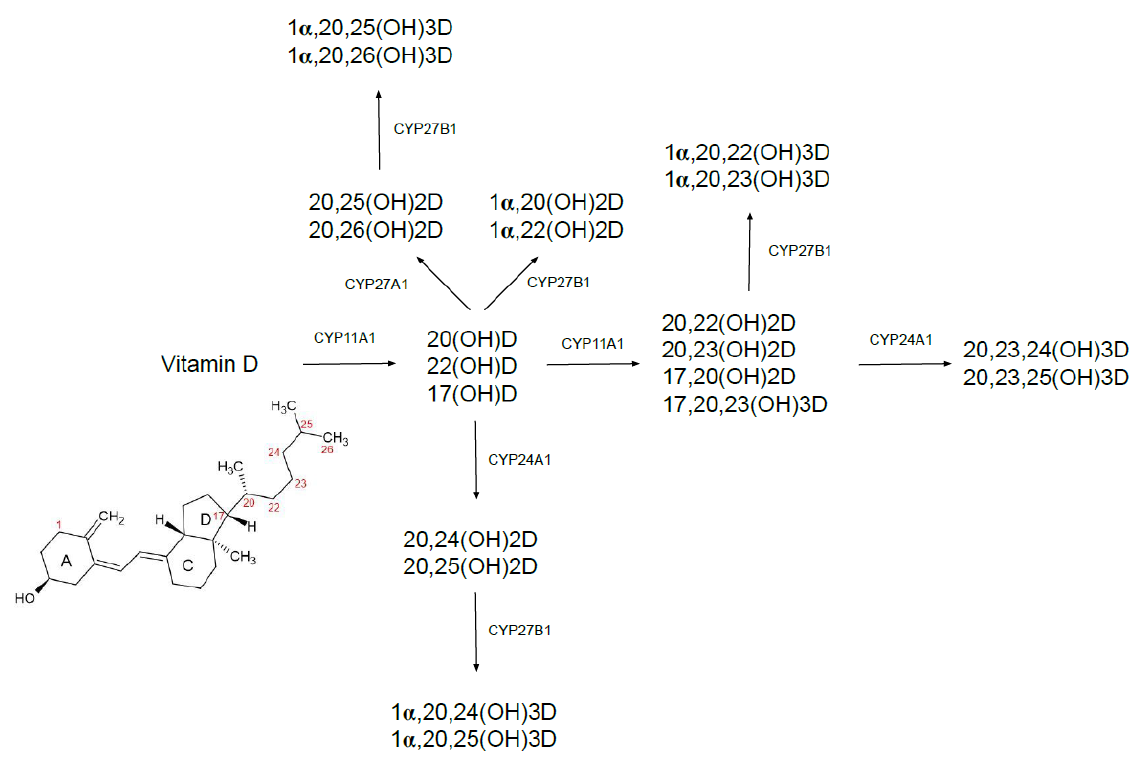
Figure 1. The metabolites obtained from the CYP11A1 mediated alternative vitamin D metabolic pathway [27,29,30,32].